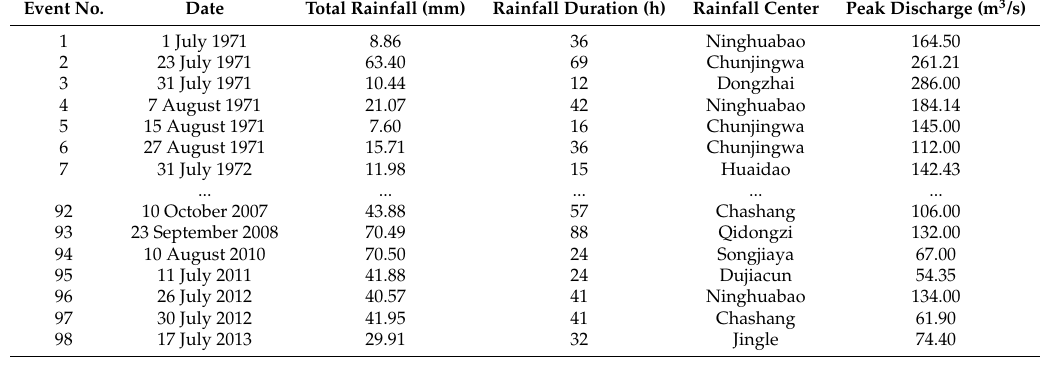
Table 1. Characteristics of collected flood events in Jingle discharge station.